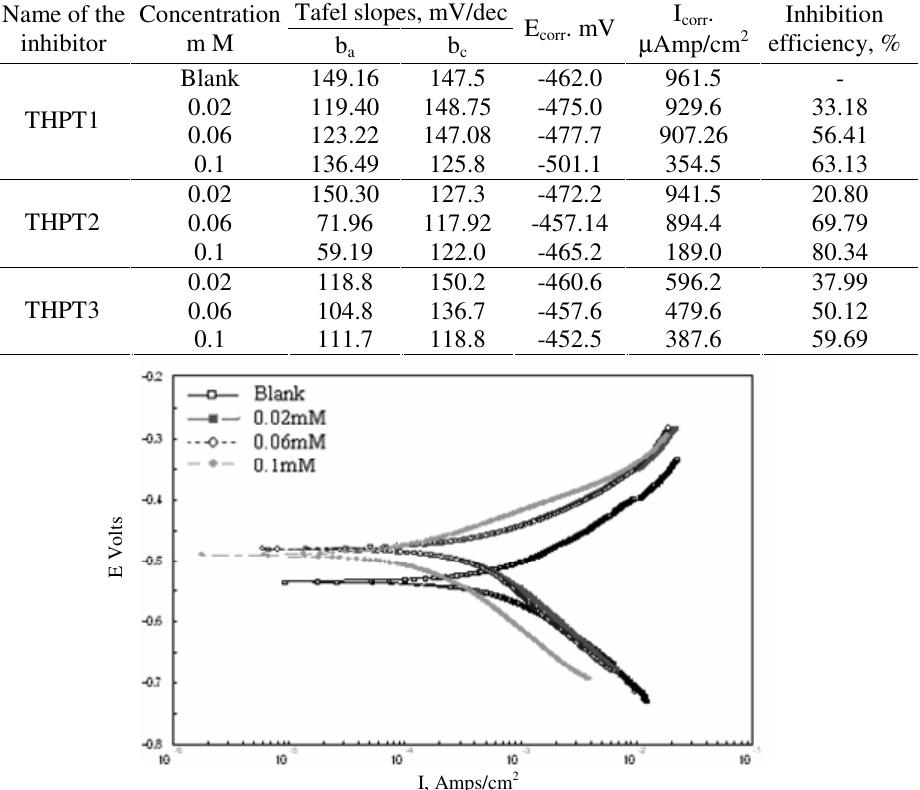
SO for selected 2 4